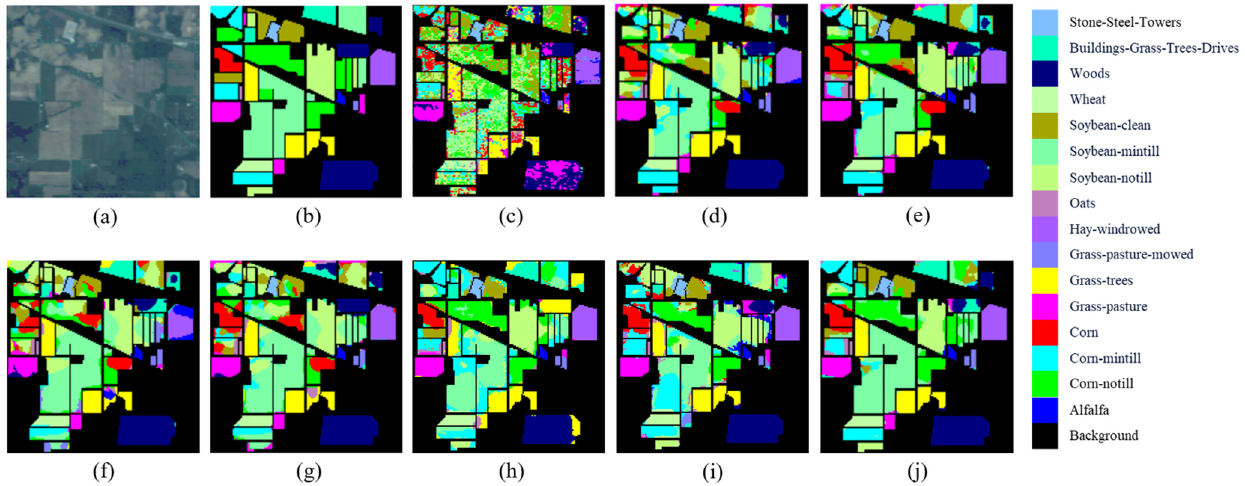
Figure 14. Classification maps of various HSI classification methods on IP dataset. ( a ) False-Color maps. ( b ) Ground Truth. ( c – j ) SVM, SSRN, RSAKGN, DFSL + NN, DFSL + SVM, DCFSL, FSL-EGNN, and GDAFSL, respectively.